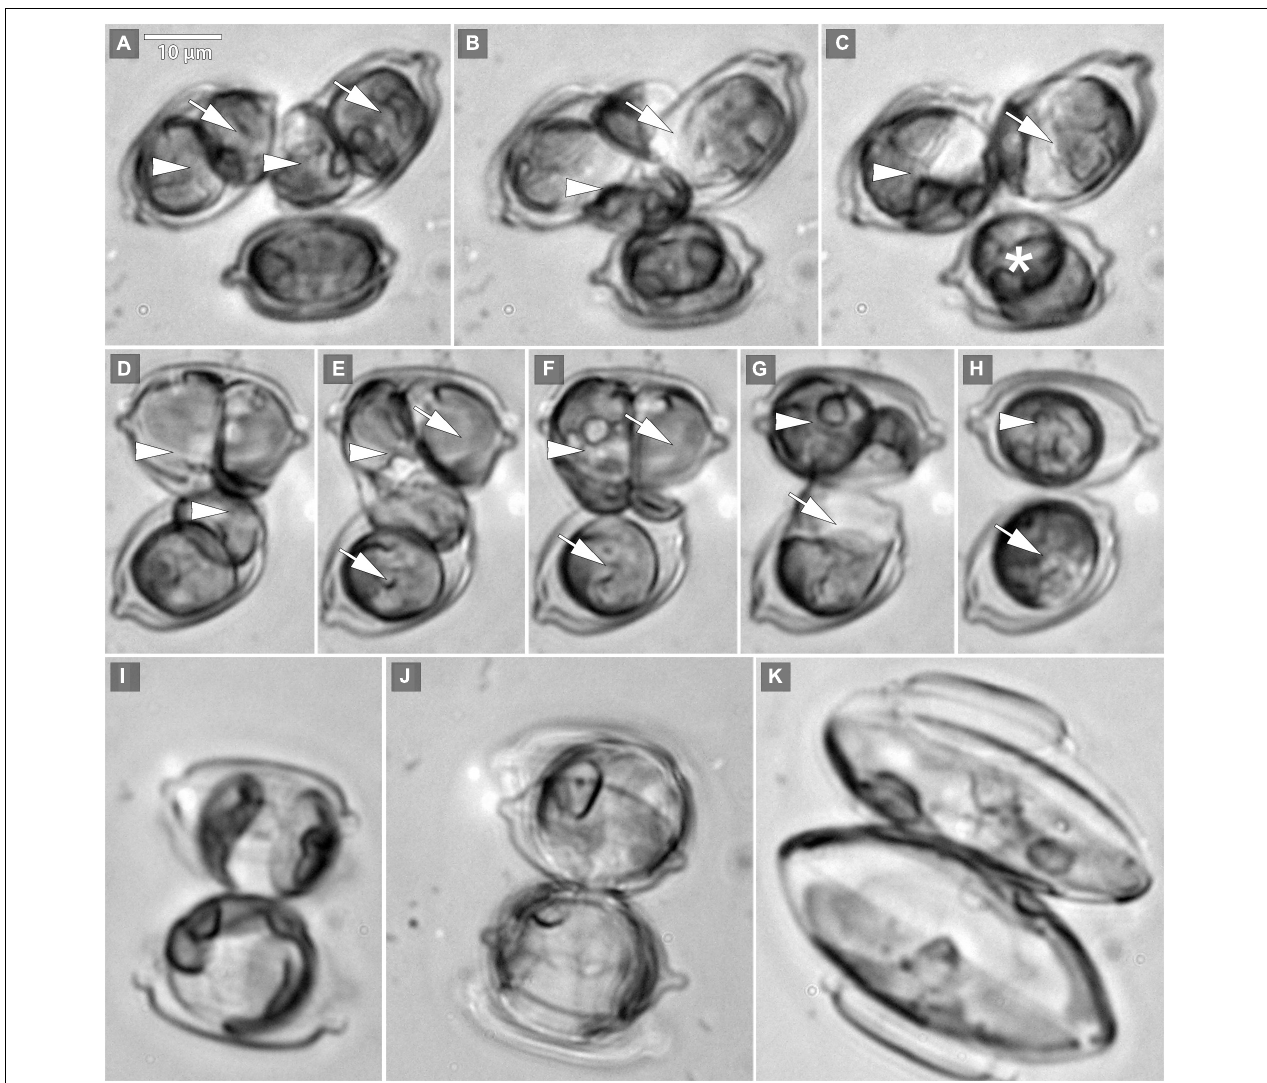
FIGURE 1 | Microphotographs of Schizostauron trachyderma auxosporulation using light microscopy (LM). (A) Two pairs of gametes formed within a gametangial cell (arrowheads mark pair 1, arrows mark pair 2). (B) Gametes simultaneously fuse crosswise (arrowhead marks pair 1, arrow marks pair 2). (C,H) Zygotes (arrows and arrowheads) and gametes of an unpaired cell (asterisk) that will not reproduce successfully. (D–G) Two pairs of gametes (arrowheads mark pair 1, arrows mark pair 2), fusing crosswise, consequently. (I–K) Two growing